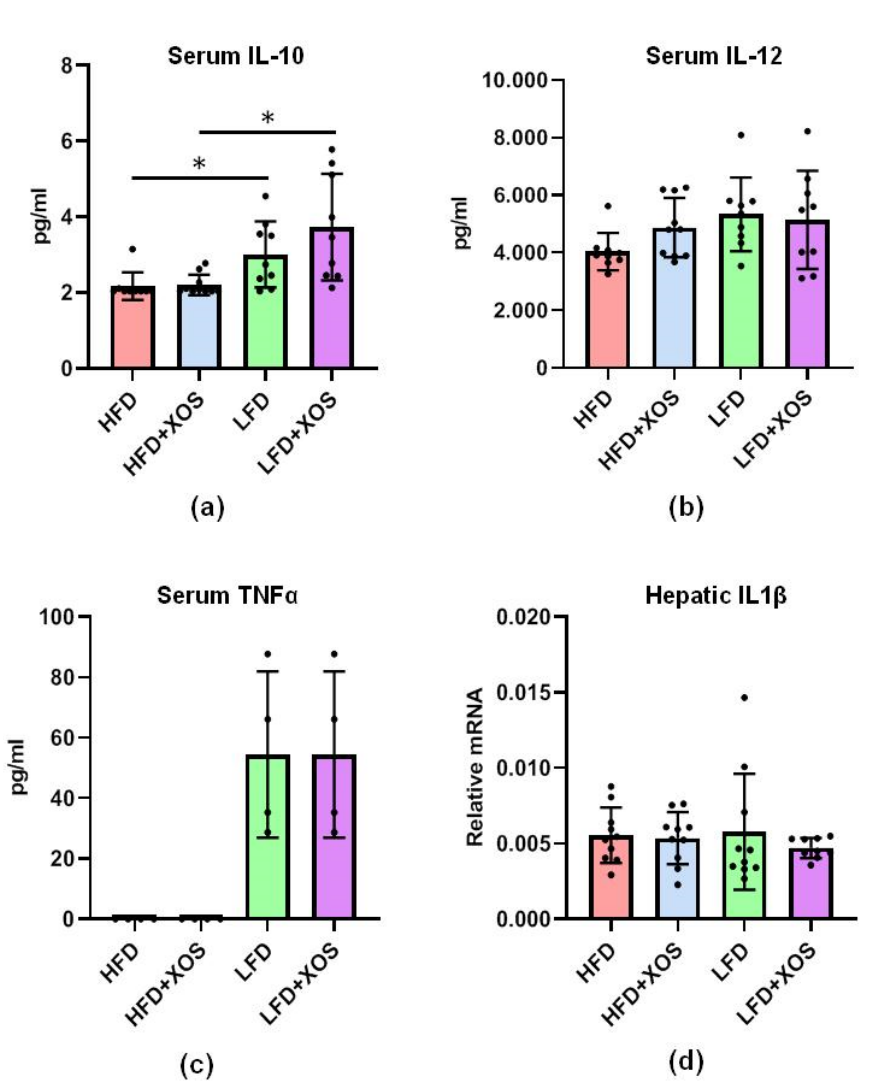
Figure 9. XOS supplementation did not affect the serum levels of ( a ) IL-10; ( b ) IL-12 or; ( c ) TNF α or; ( d ) the hepatic IL1 β mRNA but the LFD groups had higher levels of anti-inflammatory IL-10. The serum cytokines were analyzed after 12 weeks of diet intervention using 9-plex ELISA, Quansys and Q-View software. Out of nine cytokines, only the levels of IL-10, IL-12 and TNF α were detectable in rats. IL1 β mRNA was analyzed from hepatic cDNA with qPCR. n = 8–10/diet group. The different data points are shown with black dots in all graphs. * indicates statistically significant difference between the groups in all graphs.